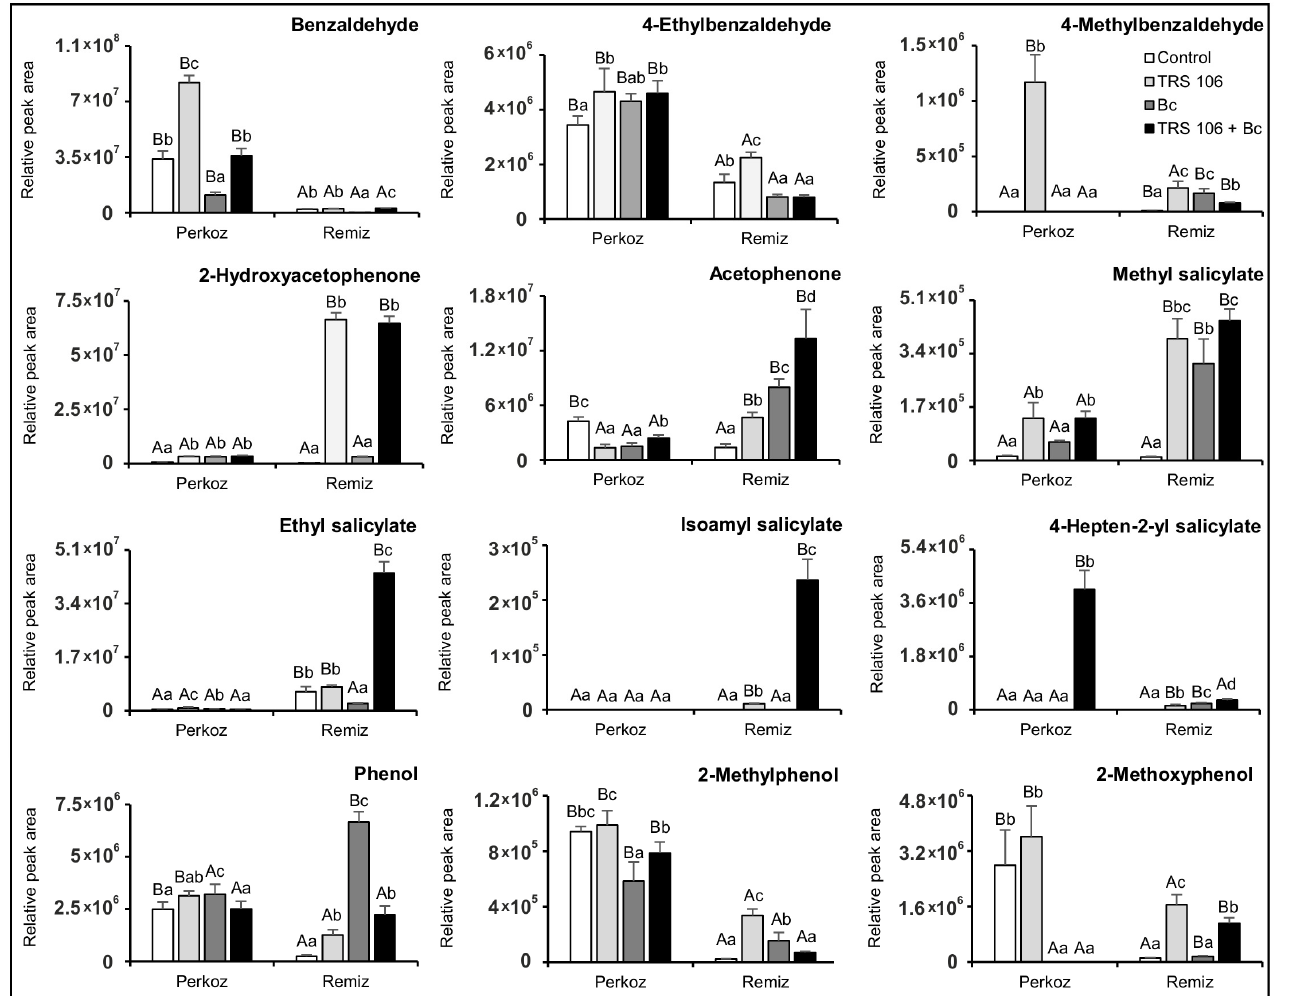
Figure 8. Effect of TRS 106 on aromatic compounds emission. Values represent the means + SE from five independent experiments (n = 5). Separately for each parameter, differences between varieties within a given variant were analyzed with Student’s t -test and marked using letters A and B. Separately for each variety, differences between all variants were analyzed with one-way ANOVA ( p < 0.05) with Tukey multiple range post hoc test. Data points followed by a different letter are significantly different at p ≤ 0.05. Abbreviations are as in Figure 1.